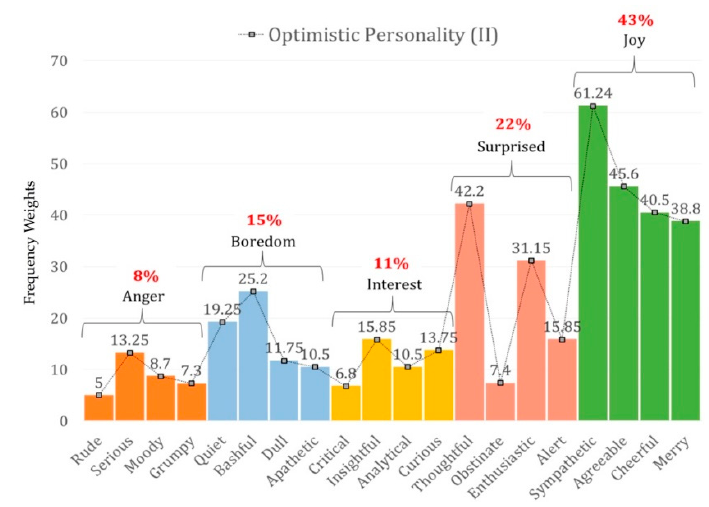
Figure 6. Optimistic Personality (Factor II): behaviors at Level 3.